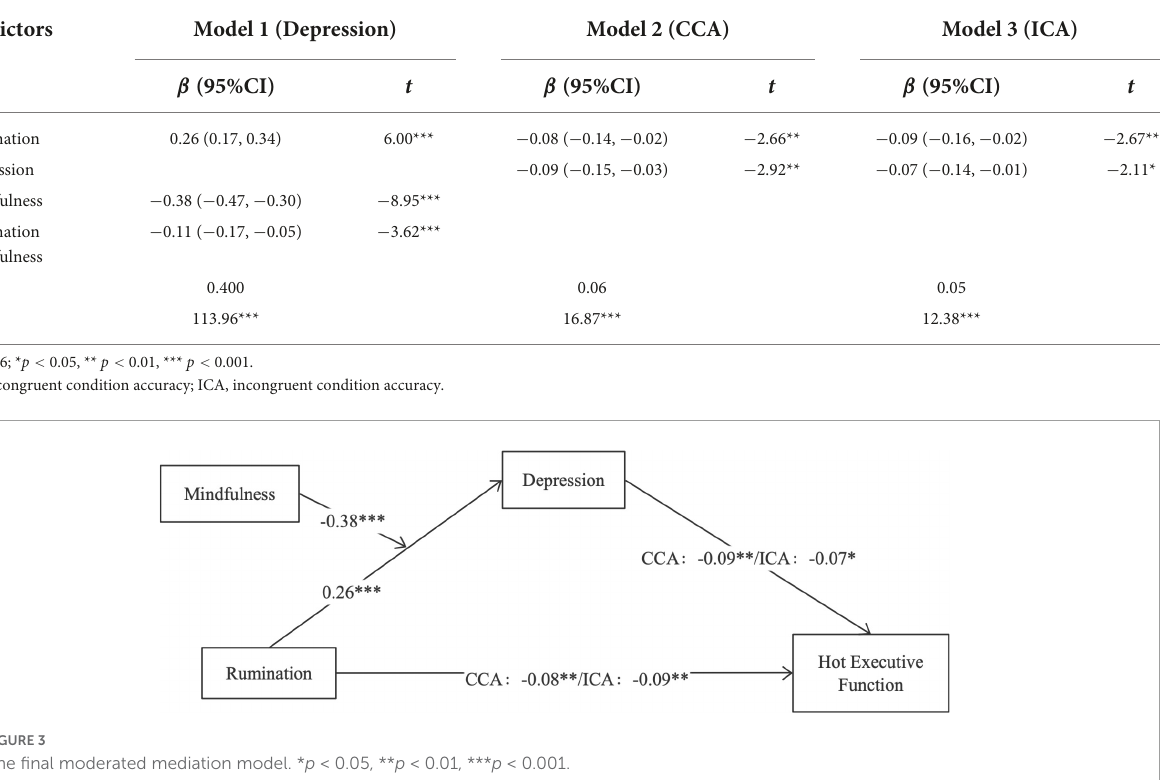
TABLE 3 The mediation effect and moderated mediation effect of rumination on hot executive function (EF).